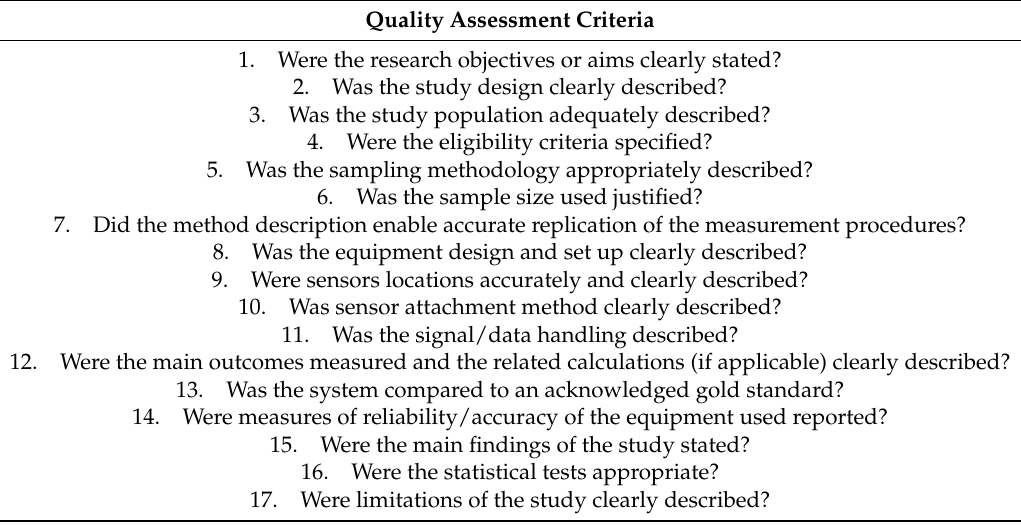
Table 3. Criteria used for the quality assessment of included